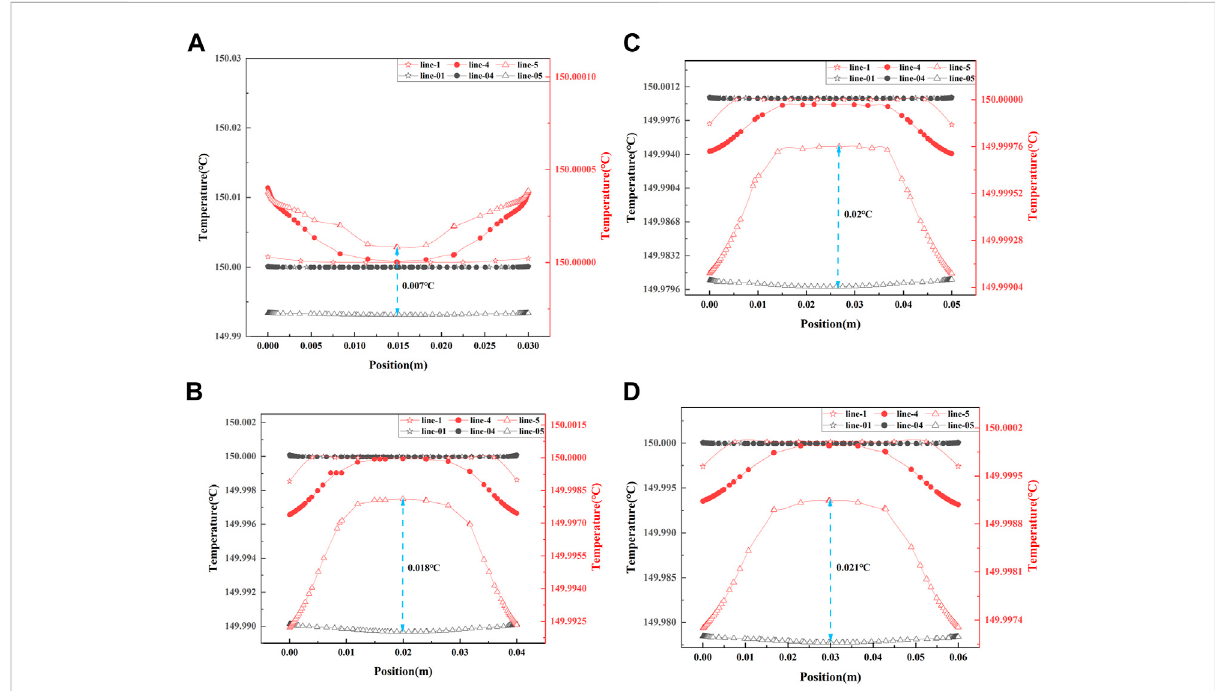
FIGURE 14 Temperature distribution along lines in the line plan: (A) model 1, (B) model 2, (C) model 3, (D) model